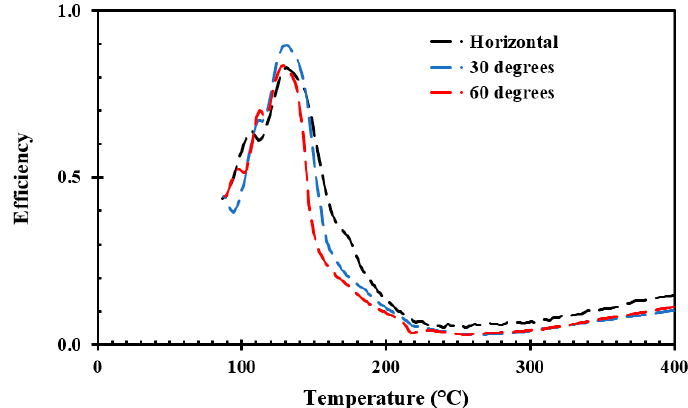
Figure 17. Cooling efficiency for 35 g/kg NaCl water solution for droplet diameter 2.5 mm, and various orientations at impingement height 25 cm (speed 2.2 m/s).